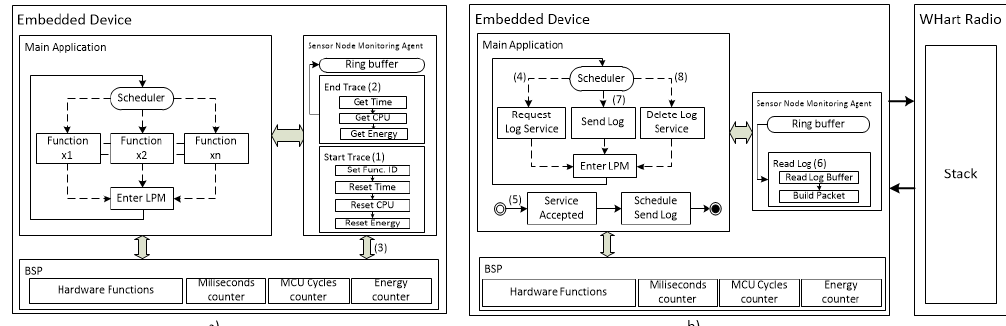
Figure 3. On the left, ( a ) the application architecture and the sensor node monitoring agent acquiring the state information. On the right, ( b ) the request of the WirelessHART publish